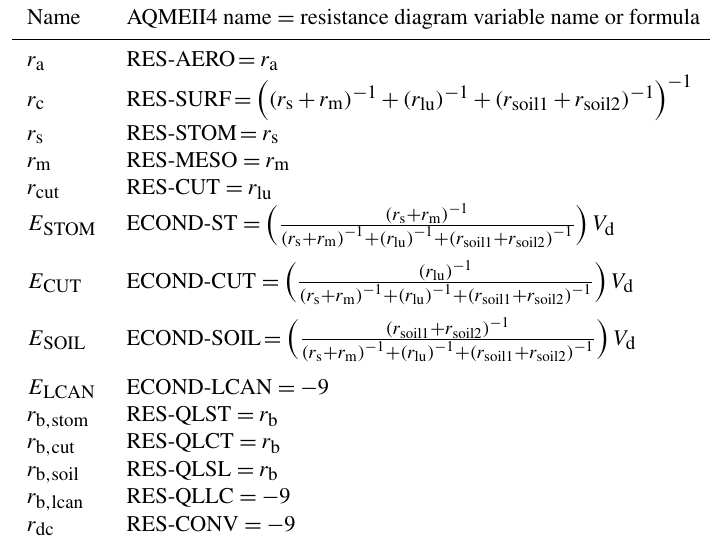
Table 6. AQMEII4 dry deposition diagnostic variables for gas-phase species corresponding to the resistance framework of Fig. 2b. Name AQMEII4 name = resistance diagram variable name or